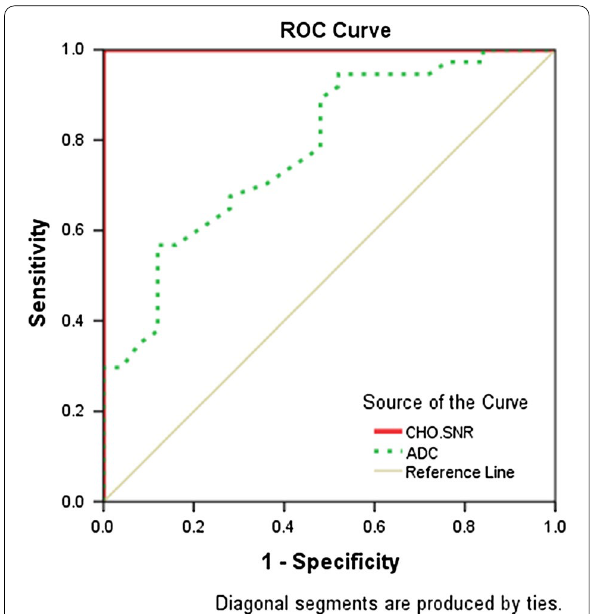
Fig. 1 ROC curve for CHO.SNR and ADC in differentiating mucinous carcinoma from